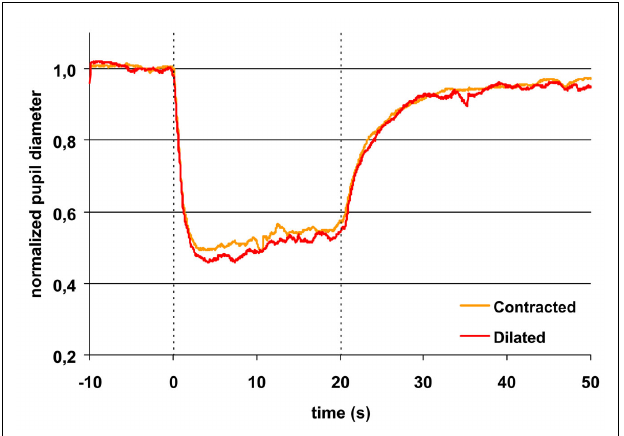
FIGURE 1 | Pupillary contraction to a red light stimulus (660nm) as a function of time (s). A constant and continuous stimulus of 300cd/m 2 was applied at time 0 and discontinued at the end of the 20th second.The stimulus was applied to the left eye and the consensual, right pupillary contraction recorded.The yellow graph represents contraction of the non-stimulated pupil, when the input pupil was contracted (miotic) in advance with pilocarpine, the red, when it was dilated (mydriatic) in advance with tropicamide.The average area of the input pupil to pilocarpine was 2.5mm 2 , and to tropicamide 44.9mm 2 . Although this difference represents a factor of 18 in retinal illuminance, the two graphs are virtually indistinguishable.Their reaction is independent of photon load. Both graphs exhibit rapid contraction to light and show pupillary escape.When the light stimulus is terminated, fairly rapid dilatation ensues. Maximal contraction is slightly larger in the red graph than in the yellow graph (cf. Table 1 ). Graphs represent mean values from 10 subjects.The pupillary contraction with the input pupil in natural state was indistinguishable from these two graphs and therefore not shown. Dashed vertical lines represent light on (0s) and light off